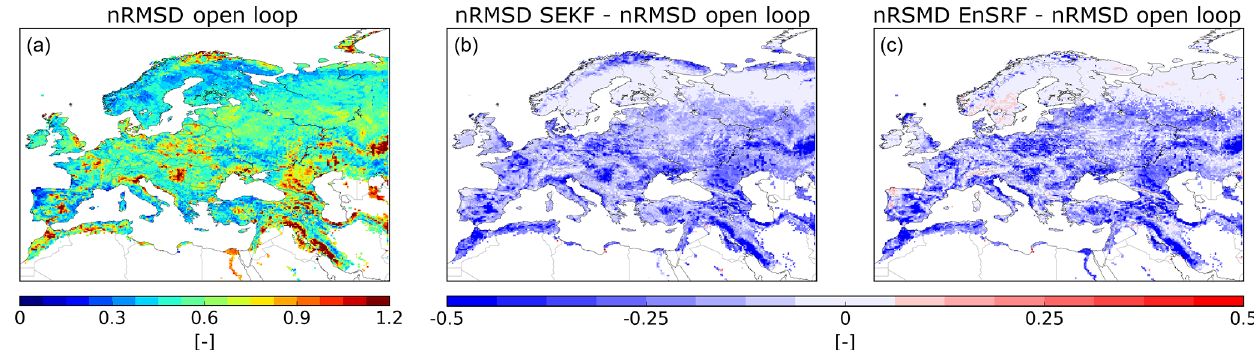
Figure 3. (a) Normalized RMSD (nRMSD) between observed LAI and its open-loop equivalent for the period 2008–2017 and the nRMSD difference between assimilation experiments (SEKF in b and EnSRF in c ) and the open loop.